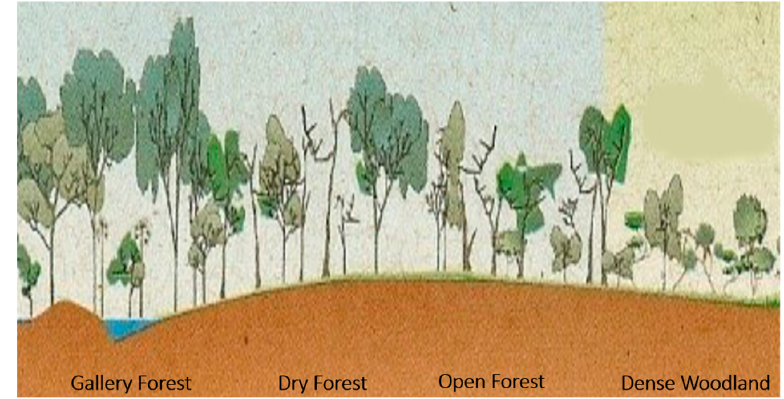
Figure 2. Cerrado biome phytophysiognomies. The graphic depicts two vegetation formations and their subdivisions in the study area, except the Dry Forest. Source: Adapted from [43].